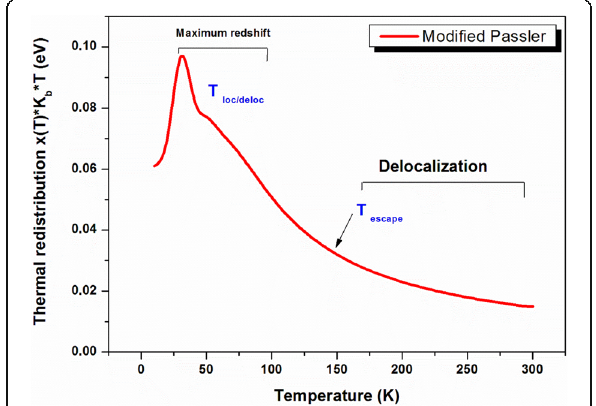
Fig. 10 Temperature-dependent thermal redistribution determined numerically. The characteristic temperatures ( T loc/deloc and T escape ) are indicated with respect to the localization-delocalization process